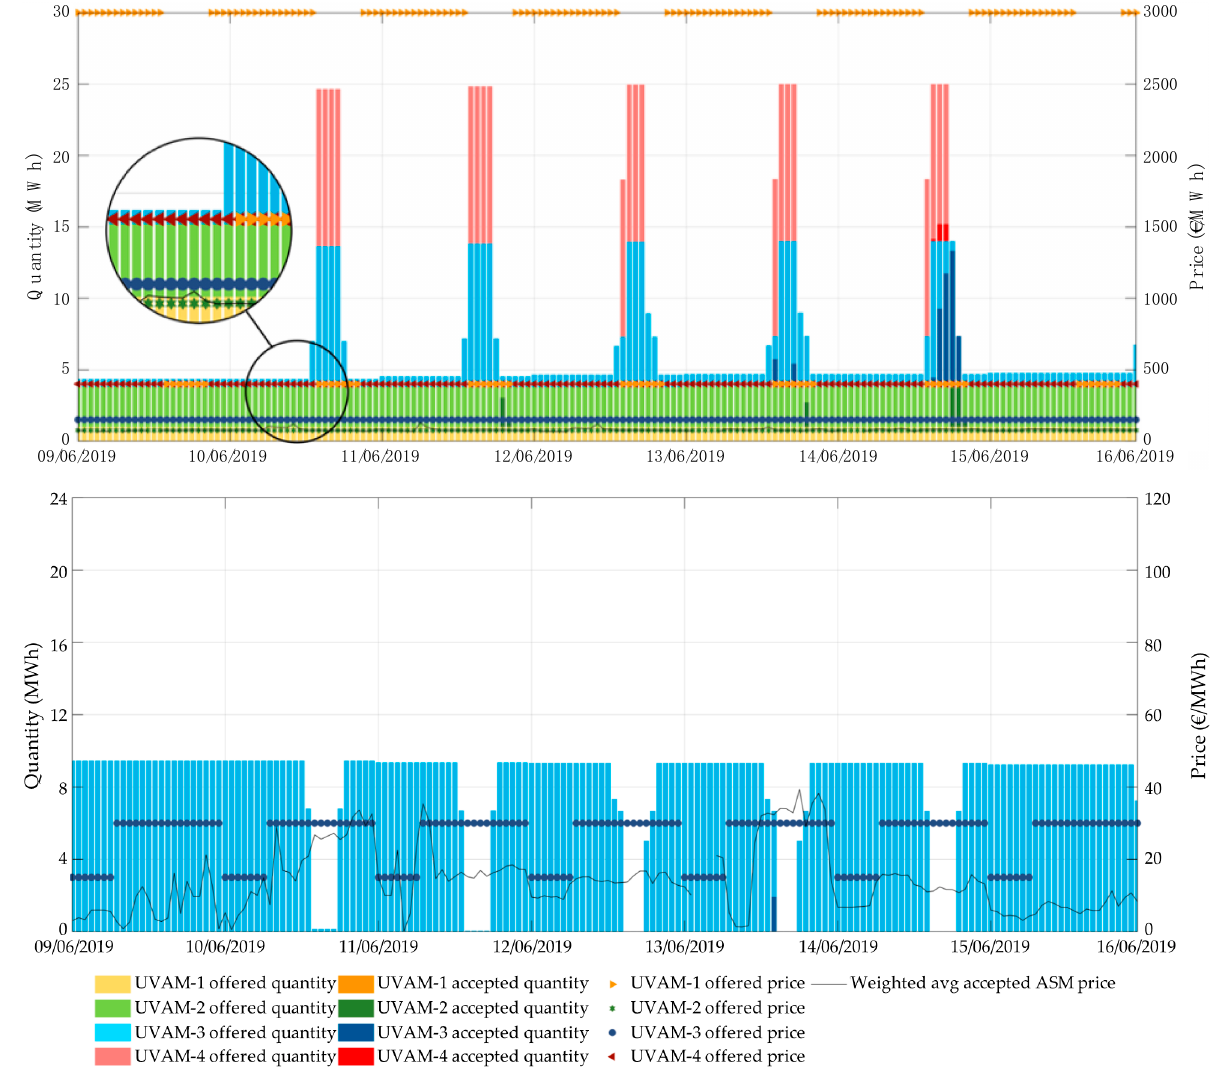
Figure 7. Hourly upward bids (chart above ) and downward bids (chart below ) of four individual UVAMs during one representative week.